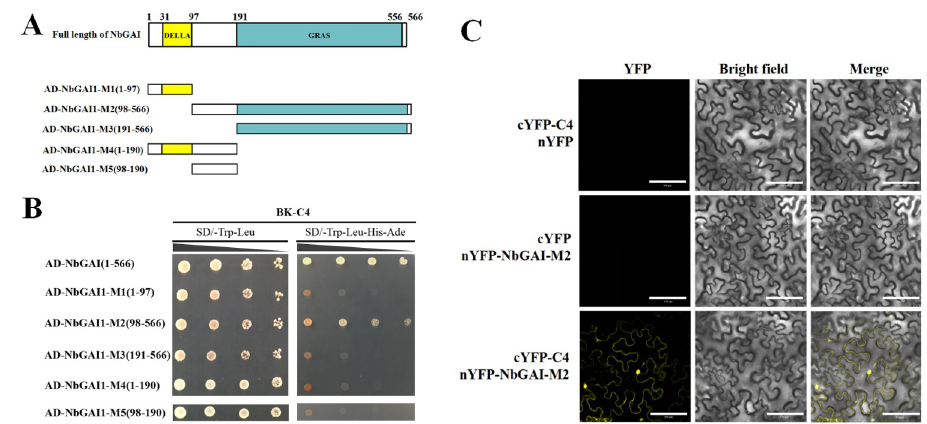
Fig 3. The middle region of NbGAI is responsible for the interaction with ALCScV C4. (A) Schematic representations of the NbGAI constructs. The deletion mutants were constructed based on the predictions of the conserved domains in NbGAI. (B) Results of the Y2H assay show the positive interaction between C4 and NbGAI or C4 and NbGAI-M2. (C) Results of the BiFC assay show the interaction between NbGAI-M2 and C4 in planta . Scale bar = 100 μ m. The procedures of the Y2H and BiFC assays are similar to those described in Fig 2.